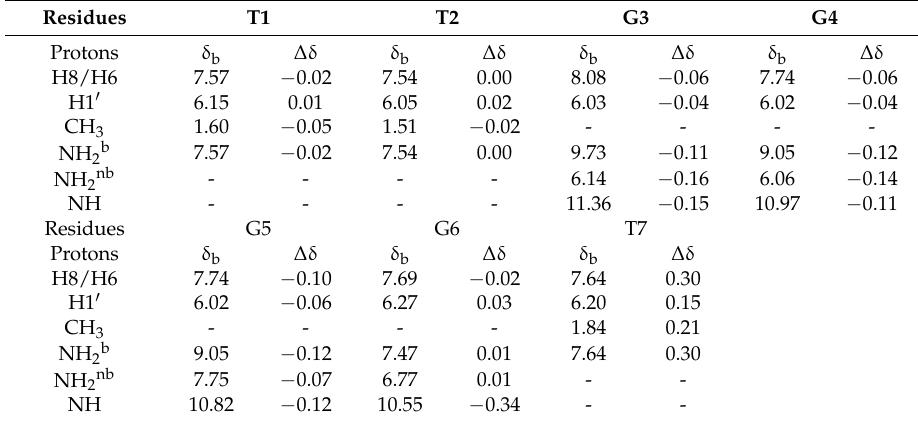
Table 1. 1 H Chemical shift (ppm) of protons in daunomycin [d-(TTGGGGT)] 4 complex ( δ b ) at D/N = 4.0 in KBPES buffer containing 100 mM of KCl (90% H 2 O + 10% D 2 O solvent) at 25 ◦ C. ∆ δ refers to a change in chemical shift due to binding. − ve ∆ δ indicates upfield